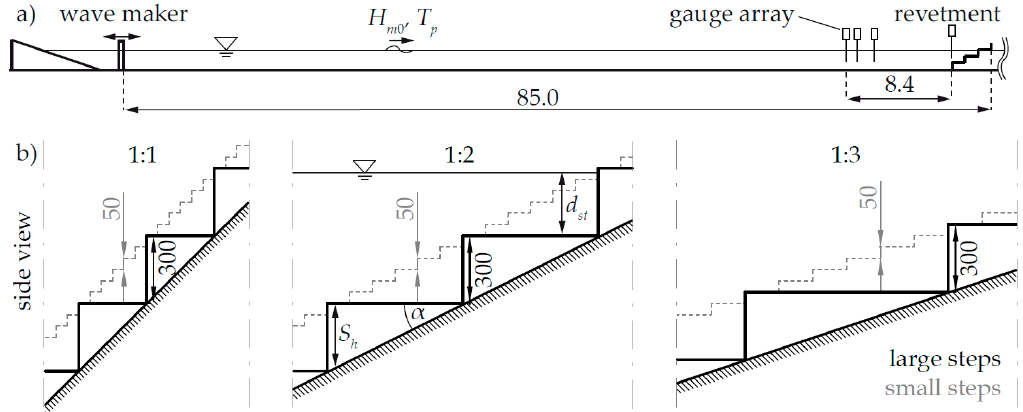
Figure 1. ( a ) Side view of the model set-up with wave gauge positions (units in meter). ( b ) Side view of the tested step geometries (units in